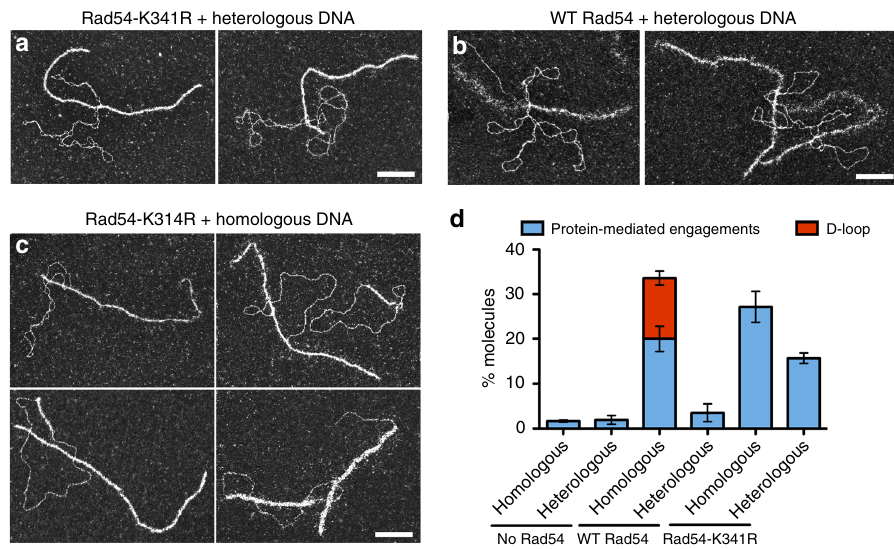
Fig. 3 Rad54K341R mutant leads to higher yield of protein-mediated engagements with heterologous DNA than WT protein. a – c Representative EM pictures of protein-mediated engagements generated during D-loop assays with a Rad54K341R and heterologous DNA, b wild-type Rad54 and heterologous DNA, and c Rad54K341R and homologous DNA. d Quanti fi cation of joint molecules generated in assays with wild-type Rad54 or